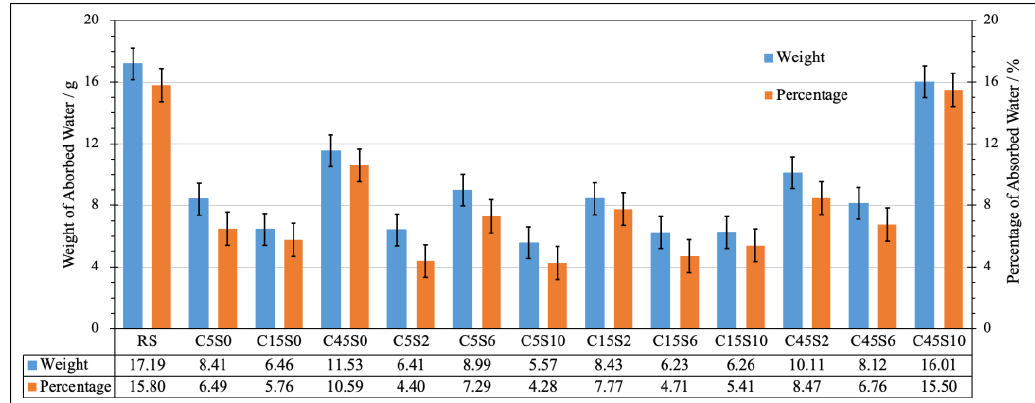
Figure 9. Results of water absorption test.